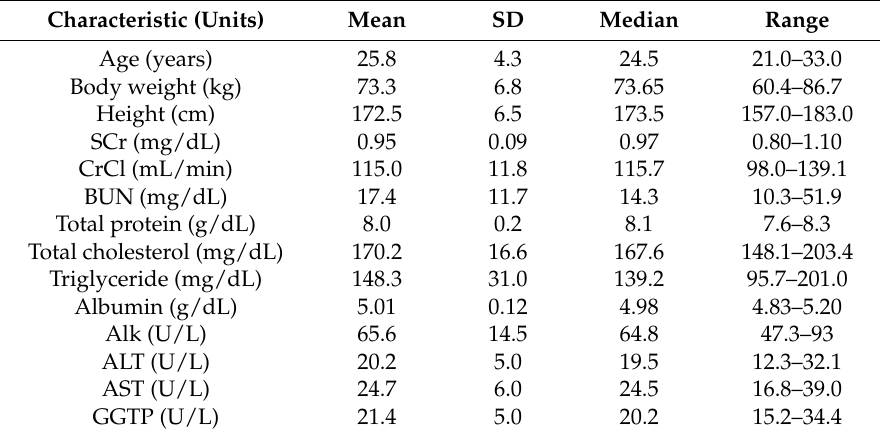
Table 3. Characteristics of 10 healthy Korean male